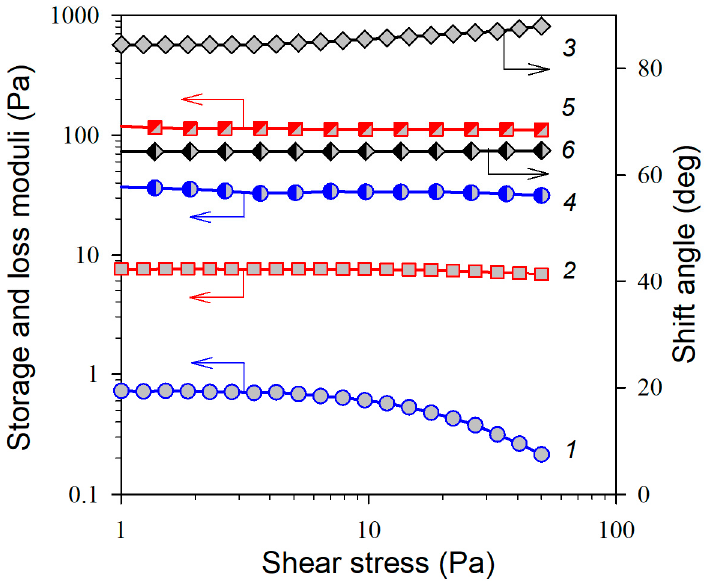
Figure 2. Shear stress dependence of the dynamic mechanical parameters for Na-alginate water solutions. Frequency of shear oscillations 1Hz, with a temperature of 25 °C. Concentration 5% (wt.):